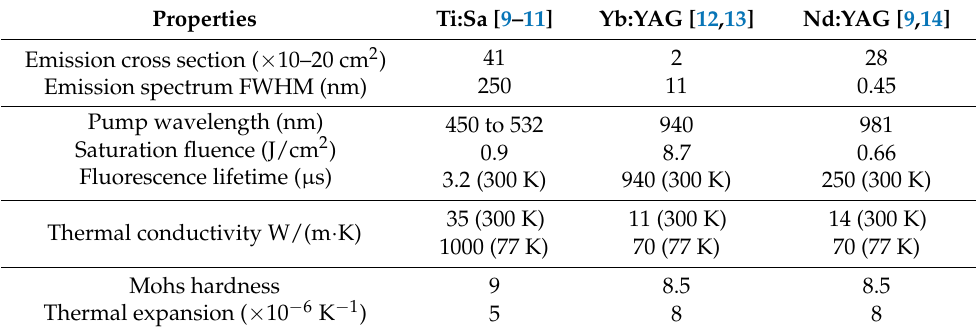
Table 1. Comparison of spectroscopic and material properties of the most common gain media for CPA, thin disk, and InnoSlab